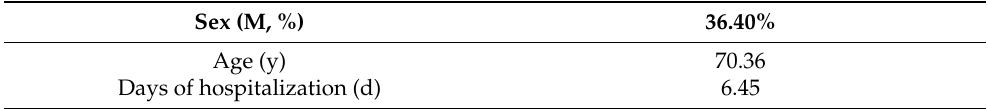
Table 2. Main characteristics of the patient undergoing an elective prosthetic surgery at Nuova Itor Hospital in